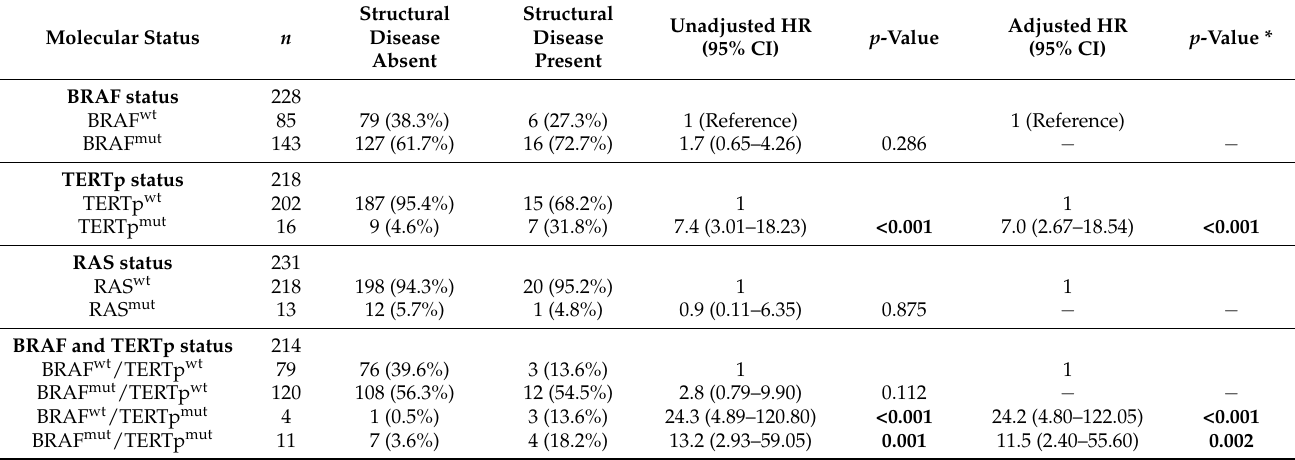
Table 4. Analysis of molecular status in the risk of structural